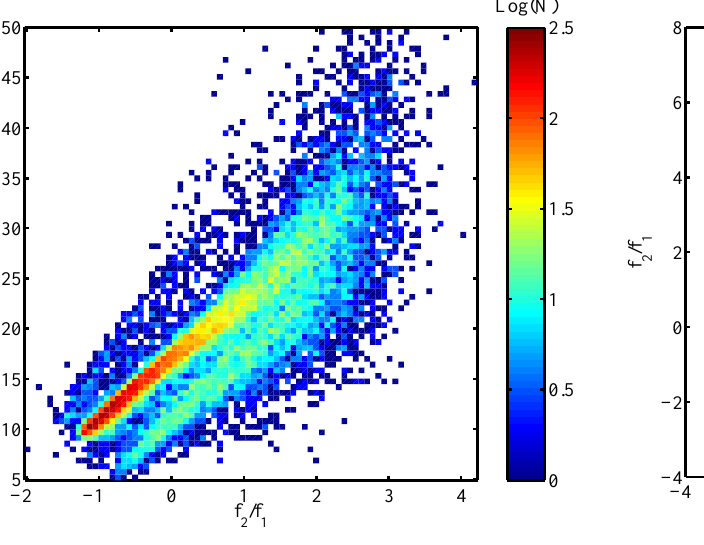
Fig. 6. Distribution of the Doppler spectral width W versus the dimensionless ratios f 2 /f 1 and f 3 /f 1 . This distribution was built using 120 2 equispaced bins. Each letter defines a region which cor- responds to a specific shape of ACF, see Fig.